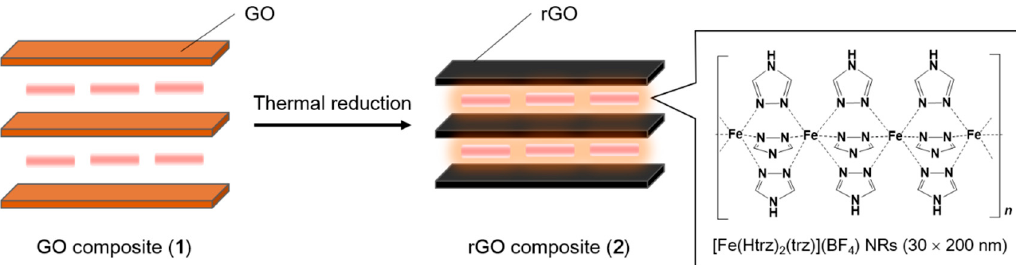
Figure 1. Schematic illustration of pressure effects in graphene oxide (GO)/ reduced graphene oxide (rGO) layers incorporating [Fe(Htrz) 2 (trz)](BF 4 ) nanorods (NRs). (rGO) layers incorporating [Fe(Htrz) 2 (trz)](BF 4 ) nanorods